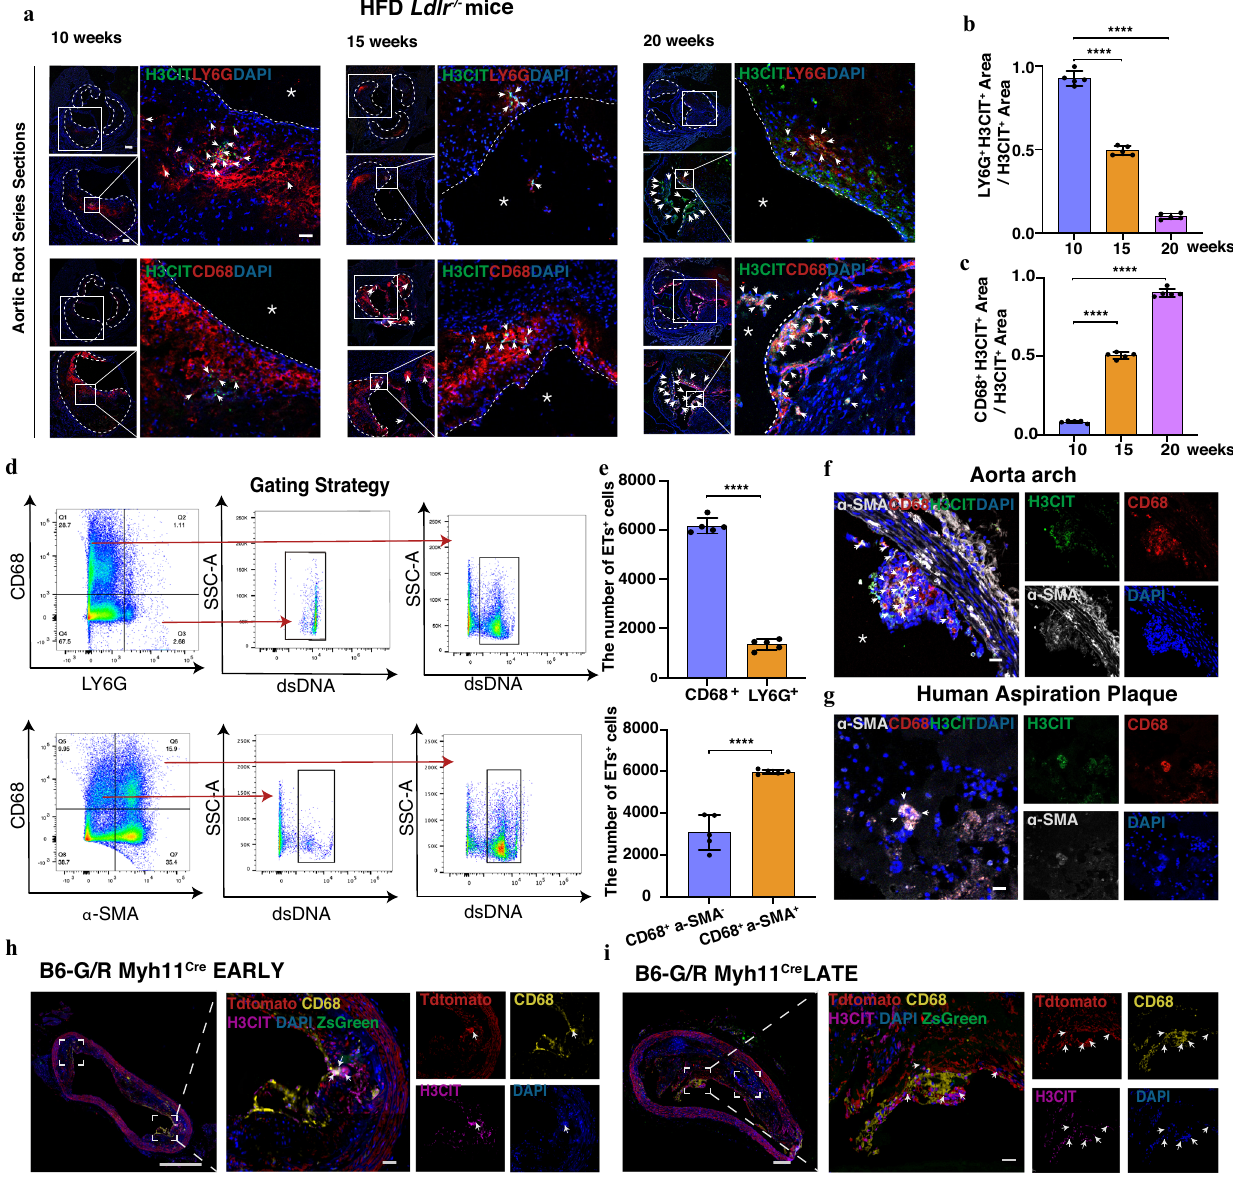
Fig.1|Neutrophilextracellulartraps(NETs)orMacrophageextracellulartraps (METs) were Generated in a Time-dependent Manner in the Development of Atherosclerosis Plaque. a Regions of 10weeks, 15weeks, and 20weeks HFD-fed mice ’ s adjacent series sections plaque had neutrophils (LY6G) co-located with H3CIT, or macrophages (CD68) co-localized with citrullinated histone H3 (H3CIT). Scale bar=200 μ m, 100 μ m, 25 μ m respectively. The white arrow showed the H3CIT + cells of Macrophages or Neutrophils. b Quanti fi cation of the ratio of ETs + neutrophil area/ETs + total area within plaque lesions harvested from three-time pointsHFDfed Ldlr -/- mice(eachtimepoint, n =5mice).(10wvs15w**** p <0.0001;